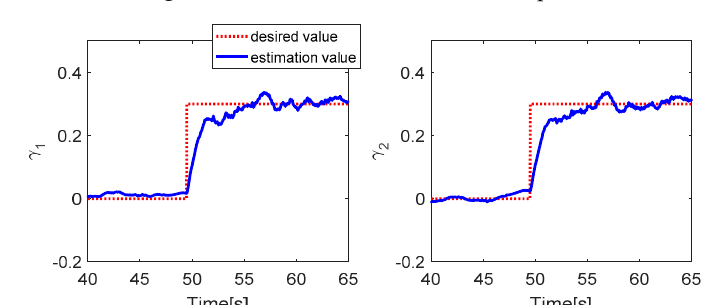
Figure 18. Fault estimation of each actuator.